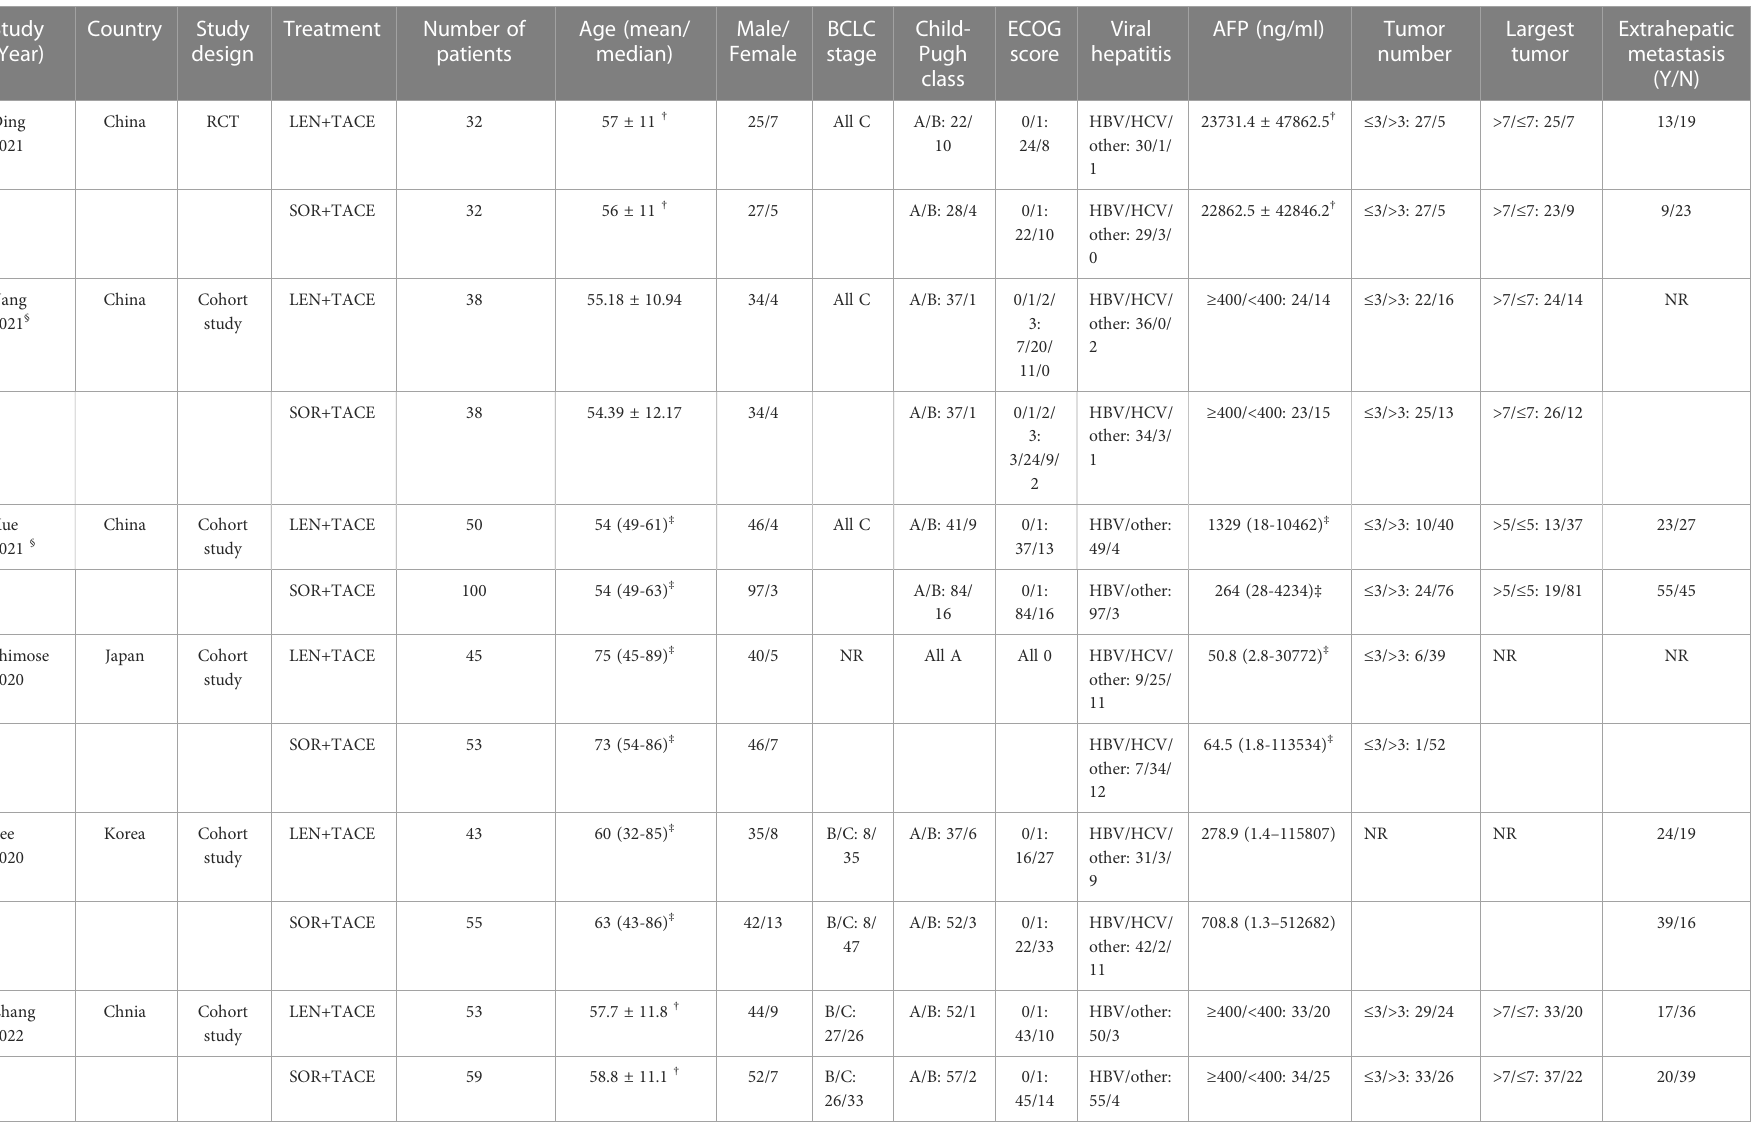
TABLE 1 Demographic characteristics of included